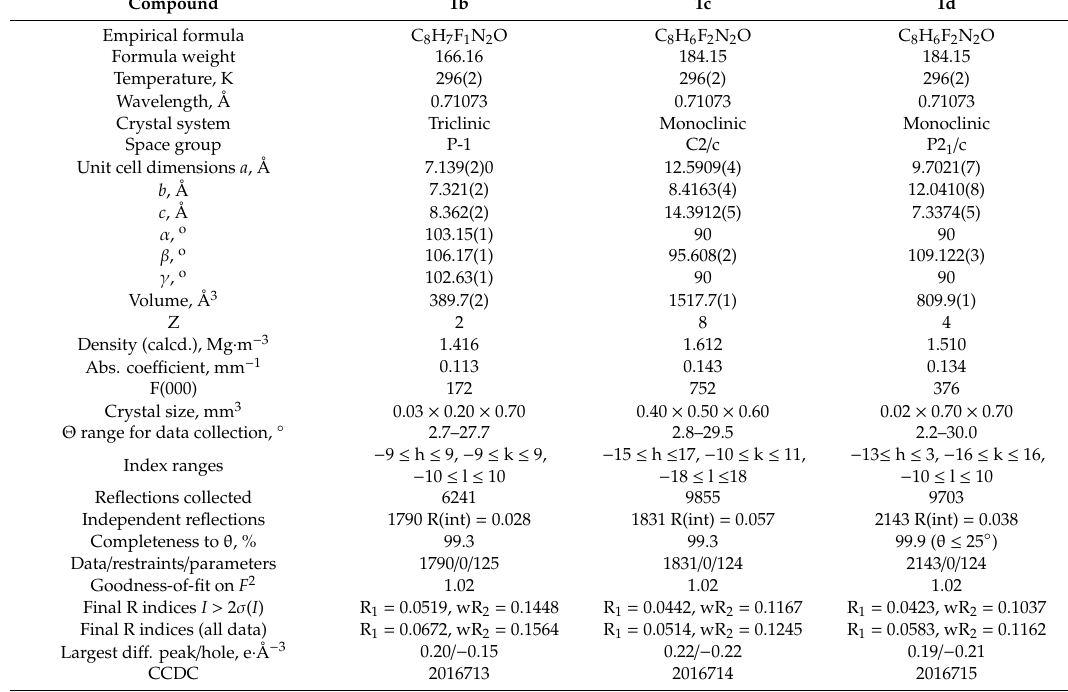
Table 2. X-ray di ff raction data for compounds 1b – e , 1g , and 1i